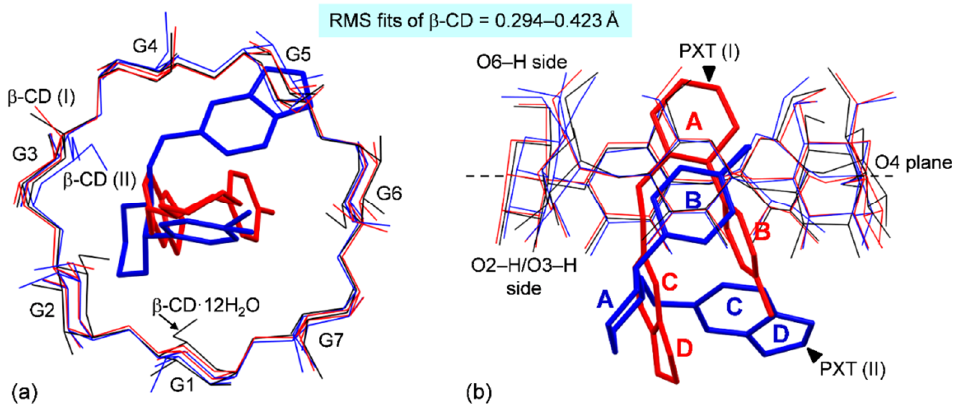
Figure 3. Structure overlays of the two β-CDs in complex with PXT (wireframes: blue—form II and red—form I (main host β-CD #2 [35]), and the uncomplexed β-CD·12H 2 O (black wireframe [40]), viewed from ( a ) the top and ( b ) the side. RMS fits are computed for the host β-CDs, excluding O6, H atoms and guests.